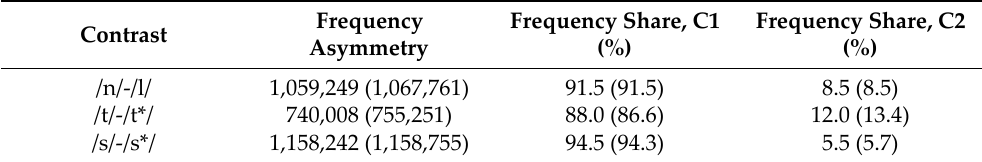
Table 4. Data from the SUBTLEX‑KR corpus on frequency asymmetries between orthographic words with the same first syllable as stimulus items in Ahn et al. (2017). Data including orthographic words with a similar first syllable containing a coda /k/ are included in parentheses. The frequency share of the first (C1) and second (C2) member of the contrast indicates the percentage of the total frequency of the contrast represented by that member. Frequency Contrast